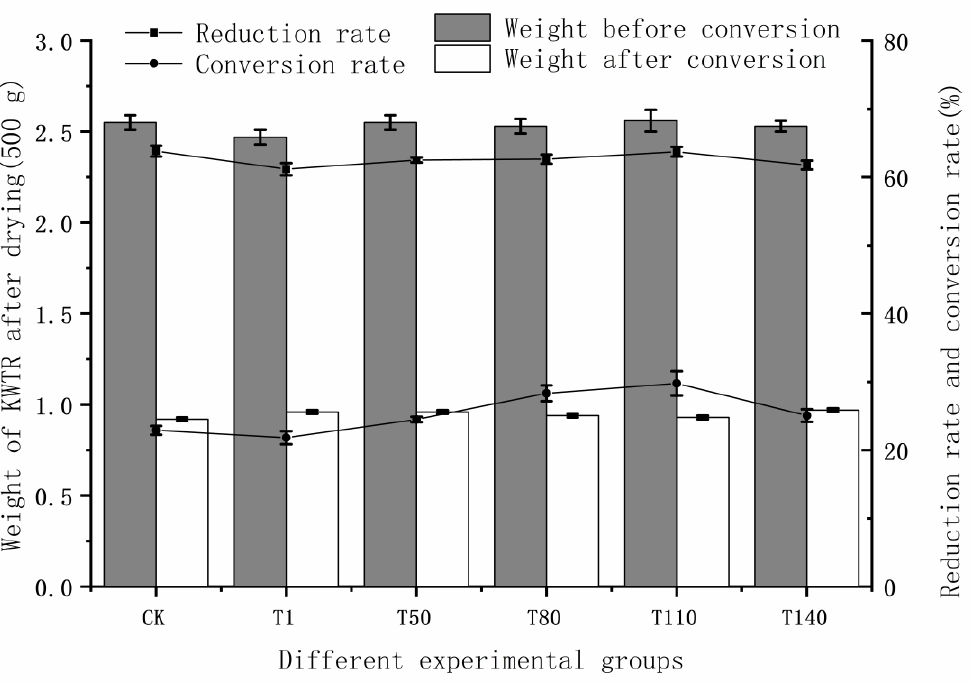
Figure 5. Effect of the amount of DKW on the reduction rate and bioconversion rate of KWTR.